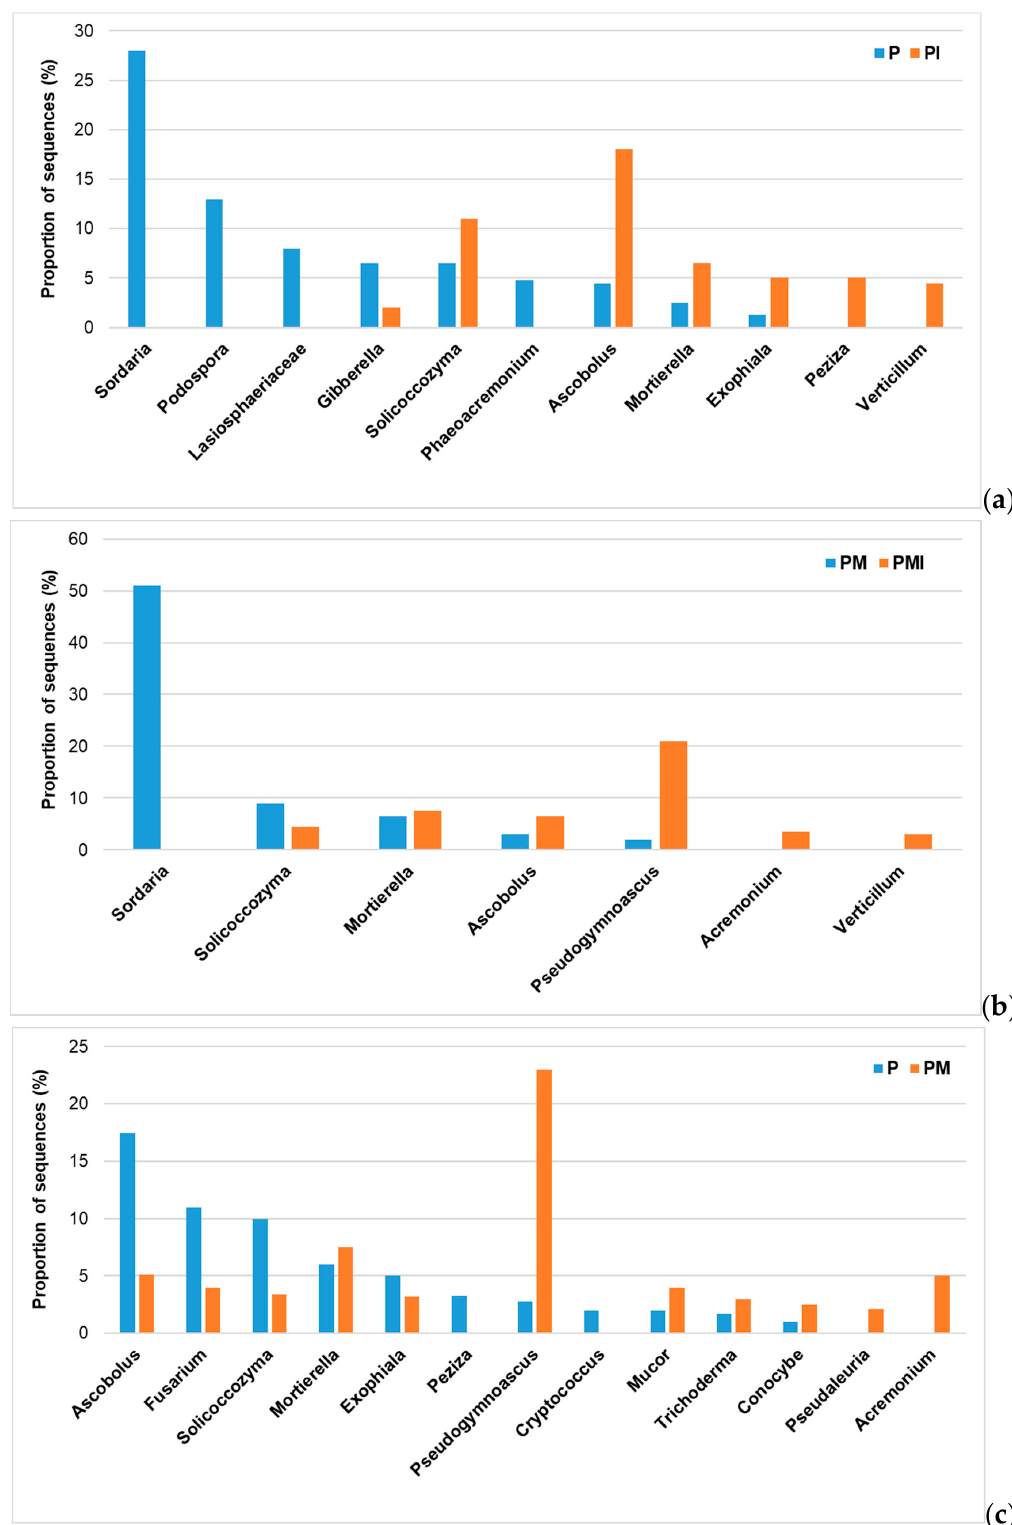
Figure 2. Proportion of sequences (%) of the main fungal genera. ( a ) Comparison of fungal genera between the rhizospheres of plants without mycorrhizal inoculation and irrigation (absolute control—P) and irrigated plants (PI). ( b ) Comparison of fungal genera between the rhizospheres of mycorrhized plants (PM) and mycorrhized and irrigated plants (PMI). ( c ) Comparison of fungal genera between the rhizospheres of control plants (P) and mycorrhized plants (PM).